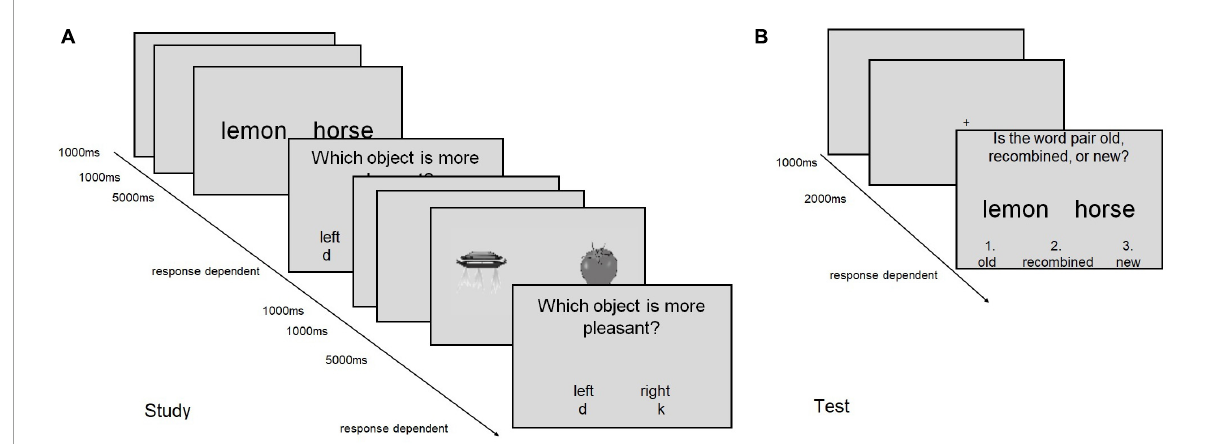
FIGURE1 Schematic display of the trial structure in (A) the encoding (study) phase, and (B) the recognition (test) phase of tasks 1 and 2. (A) Two encoding trials are shown, which each consist of the presentation of the stimulus display (5,000 ms), the response prompt (response dependent) and a blank screen (1,000 ms). Between two trials, a fixation cross is shown (1,000 ms). The encoding trial structure applies to all tasks except for task 3, in which no rating screen was shown. (B) A recognition trial is shown, in which the correct response would be “old.” The same procedure applies to Task